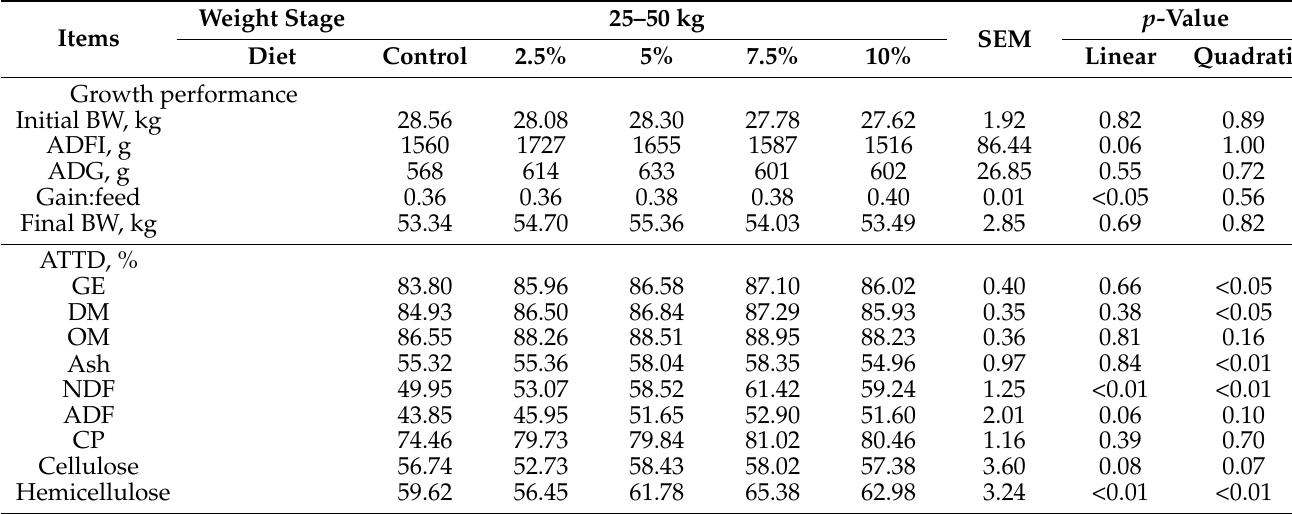
Table 3. Effects of inclusion level of defatted rice bran on growth performance and apparent total tract digestibility in weight stage 1 1 .